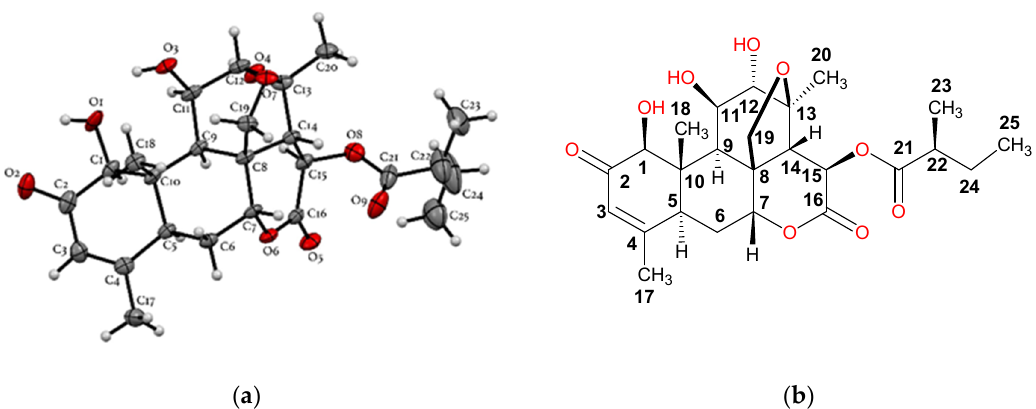
Figure 4. ( a ) Illustration of the crystal structure of SKD with thermal ellipsoids drawn at 50% probability; ( b ) structure of SKD showing all the chiral centers. To facilitate analysis, the carbon numbering system for Positions 17 to 25 are the same as those generated for the X-ray structure (Figure S27, Supplementary Materials).